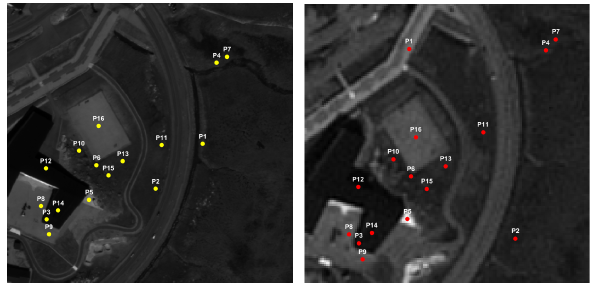
Figure 2: Matched feature points in patch number 7 in World View (1a, yellow dots) and SPOT6 image (1b, red dots) with dis-